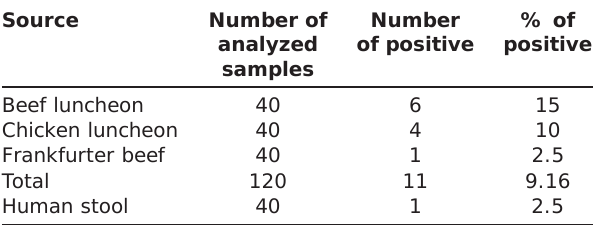
Table-2: Suspected L. monocytogenes isolates detected in RTE meat products and human stool samples.